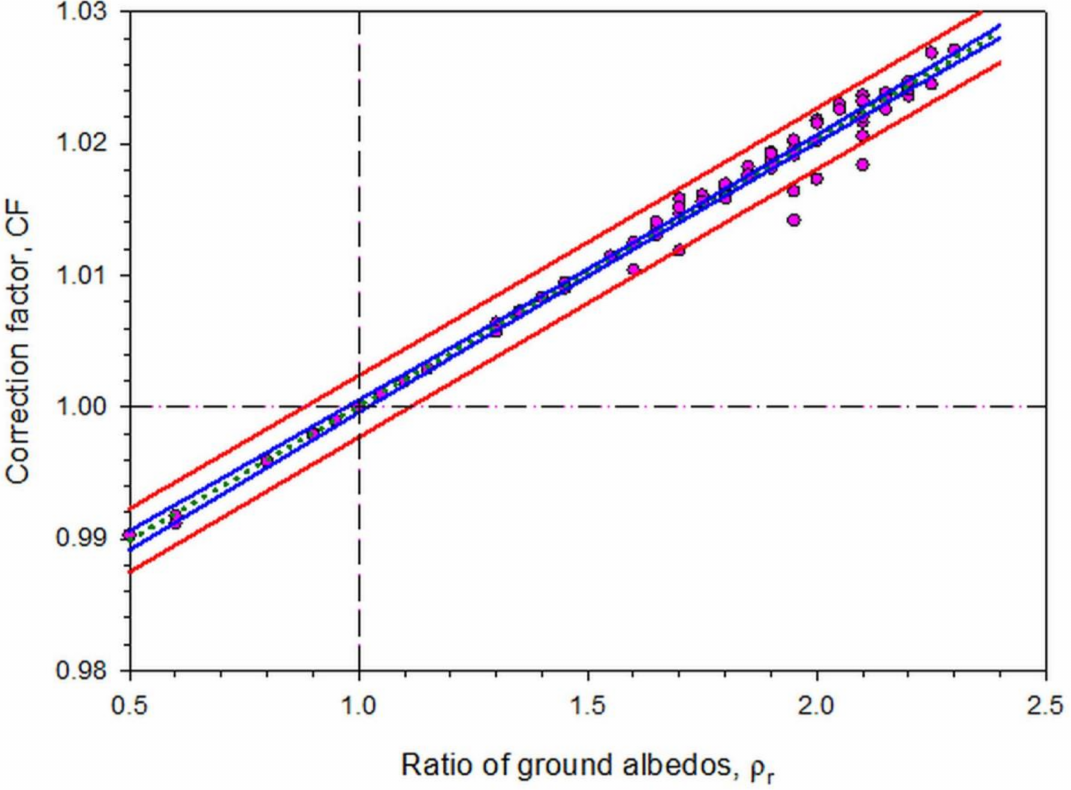
Figure 11. Variation of the correction factor, CF, as function of the ground-albedo ratio, ρ r , under all-sky conditions; both CF and ρ r data points are annual averages over each site and over the period 2005–2016. The straight dotted green line expresses the best fit to the data points. The blue and the red zones are the confidence and prediction intervals at the 95% level, respectively. The horizontal black dash-dotted line and the vertical black dashed line indicate the crossing point of CF = 1 and ρ r =